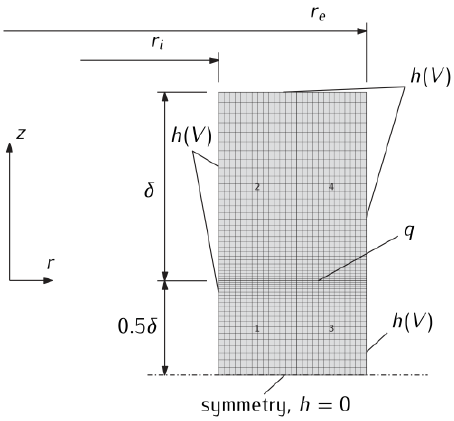
Figure 2. Finite element mesh of the three-element braking system with boundary conditions.